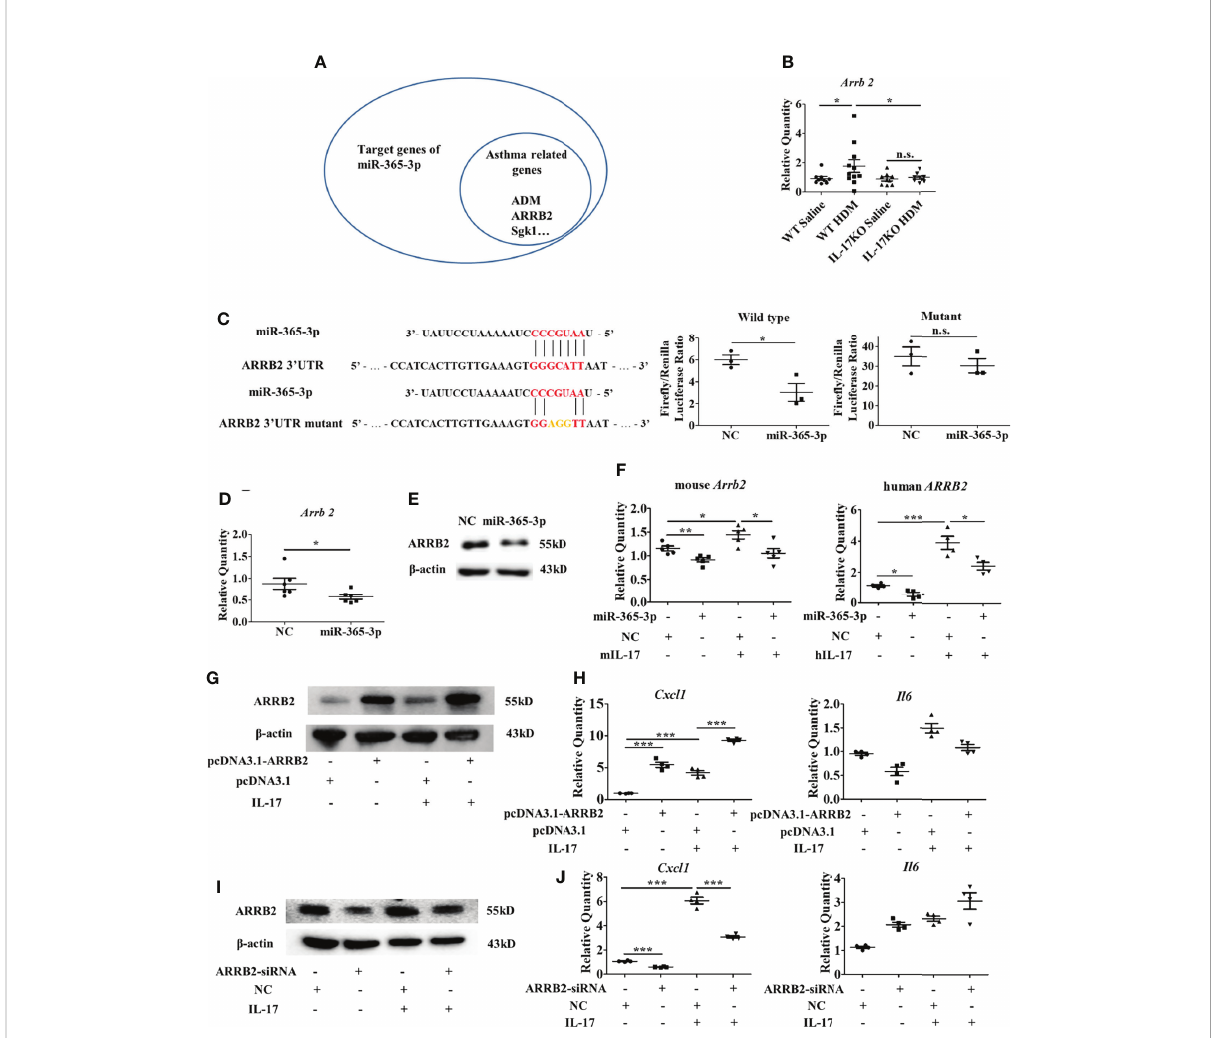
FIGURE 6 ARRB2 is the target gene of miR-365-3p to negate proin fl ammatory effect of IL-17. (A) target genes of miR-365-3p that are related with asthma. (B) mRNA expression of A RRB2 detected by qRT-PCR. N=5. (C) The targeting role of miR-365-3p on A RRB2 examined by reporter fl uorescence assays, N=3. (D) Effect of miR-365-3p rescue on mRNA level of A RRB2. N=6. (E) Effect of miR-365-3p rescue on protein level of ARRB2. (F) regulatory effect of miR-365-3p on ARRB2 expression in both mouse MLE-12 (left) and human A549 (right) epithelial cells. (G) immunoblotting analysis of ARRB2 overexpression from pcDNA3.1 vector in MLE-12 cells. (H) expression of KC and IL-6 in ARRB2-overexpression MLE-12 cells upon IL-17 treatment. N=4. (I) immunoblotting analysis of ARRB2 knockdown by siRNA in MLE-12 cells. (J) expression of KC and IL-6 in ARRB2- knockdown MLE-12 cells upon IL-17 treatment. N=4. *, P<0.05, **, P<0.01, ***, P<0.001. n.s., not statistically signi fi